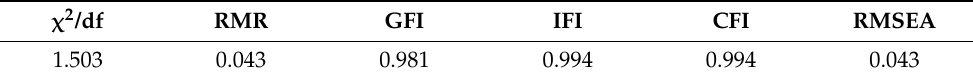
Figure 2. The results of model M1. Table 8. The fitting result of model M1. Table 8. The fitting result of model M1.